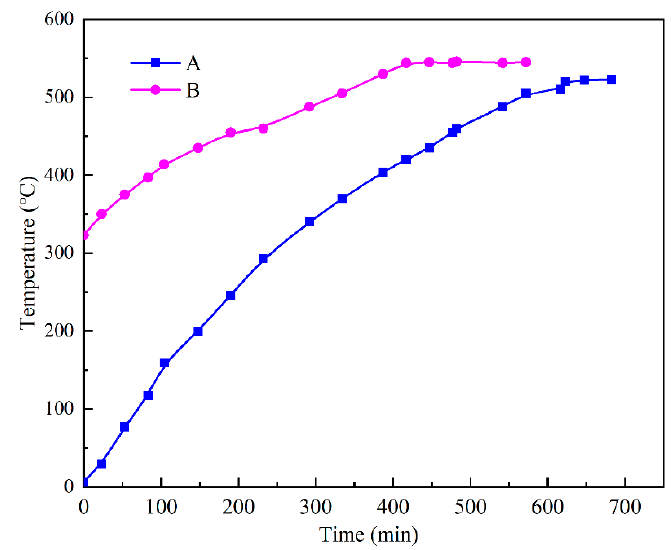
Figure 12 . Temperature change of PCM during heat storage.